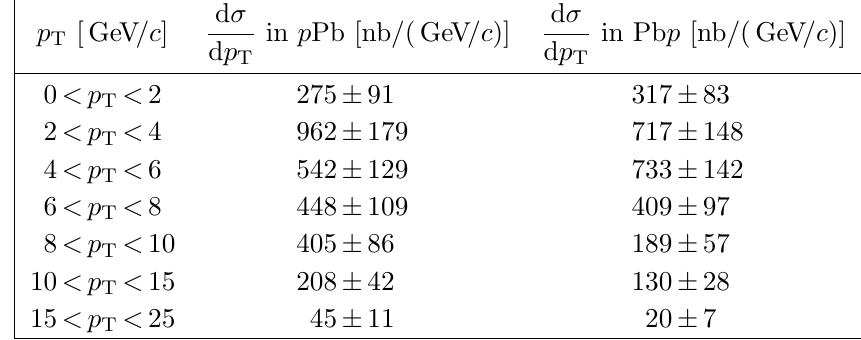
Table 8 . (cid:7) (2 S ) production cross-section in p Pb and Pb p , as a function of p T .